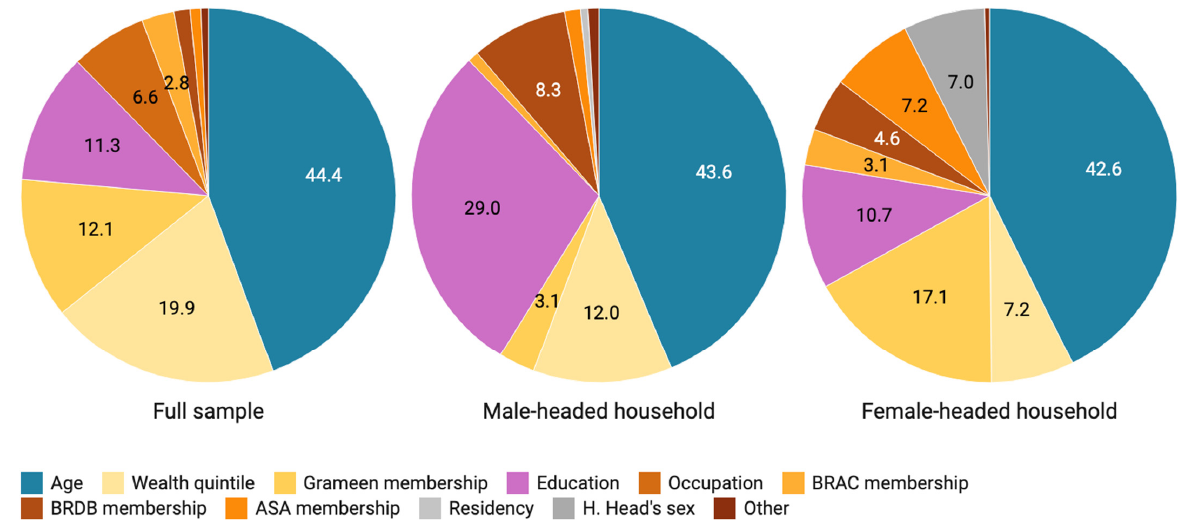
Figure 1. Variable importance plot.